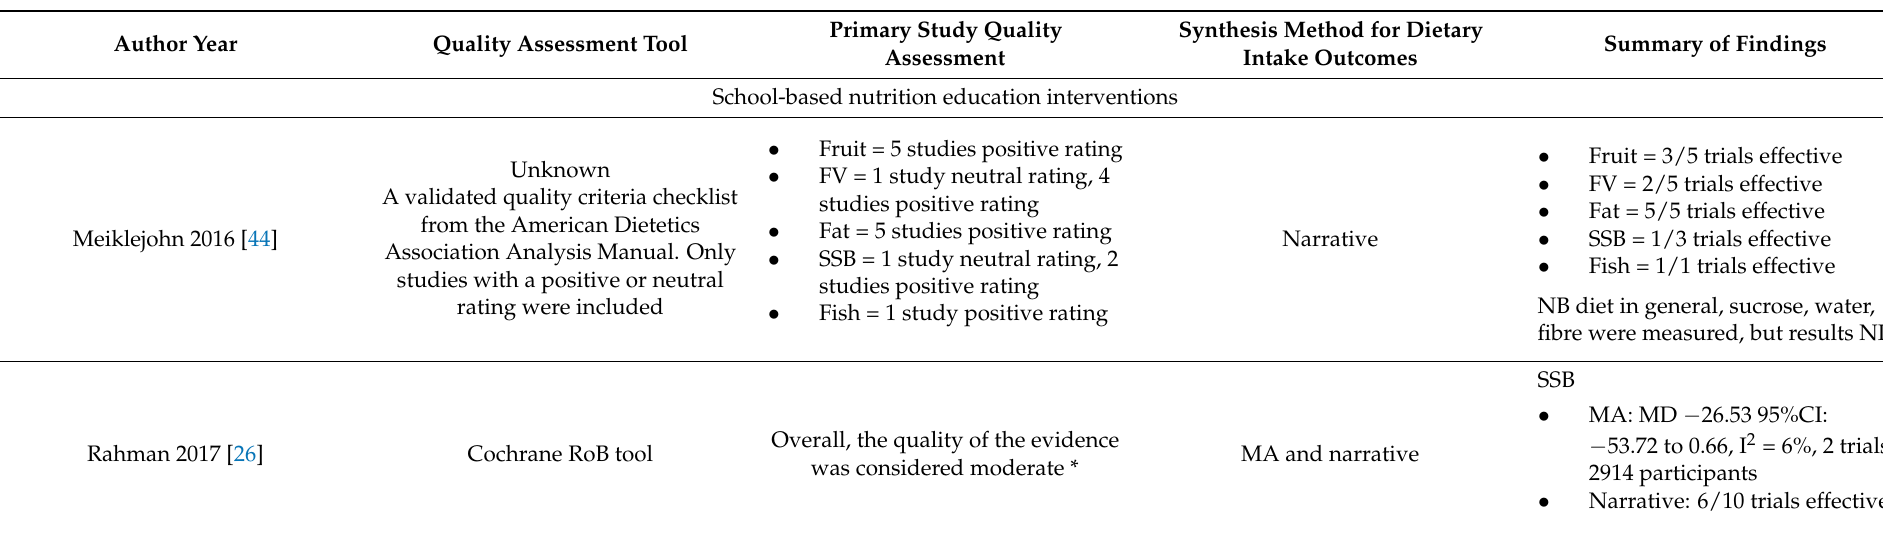
Table 3. Effects of RCTs of school-based nutrition interventions compared to